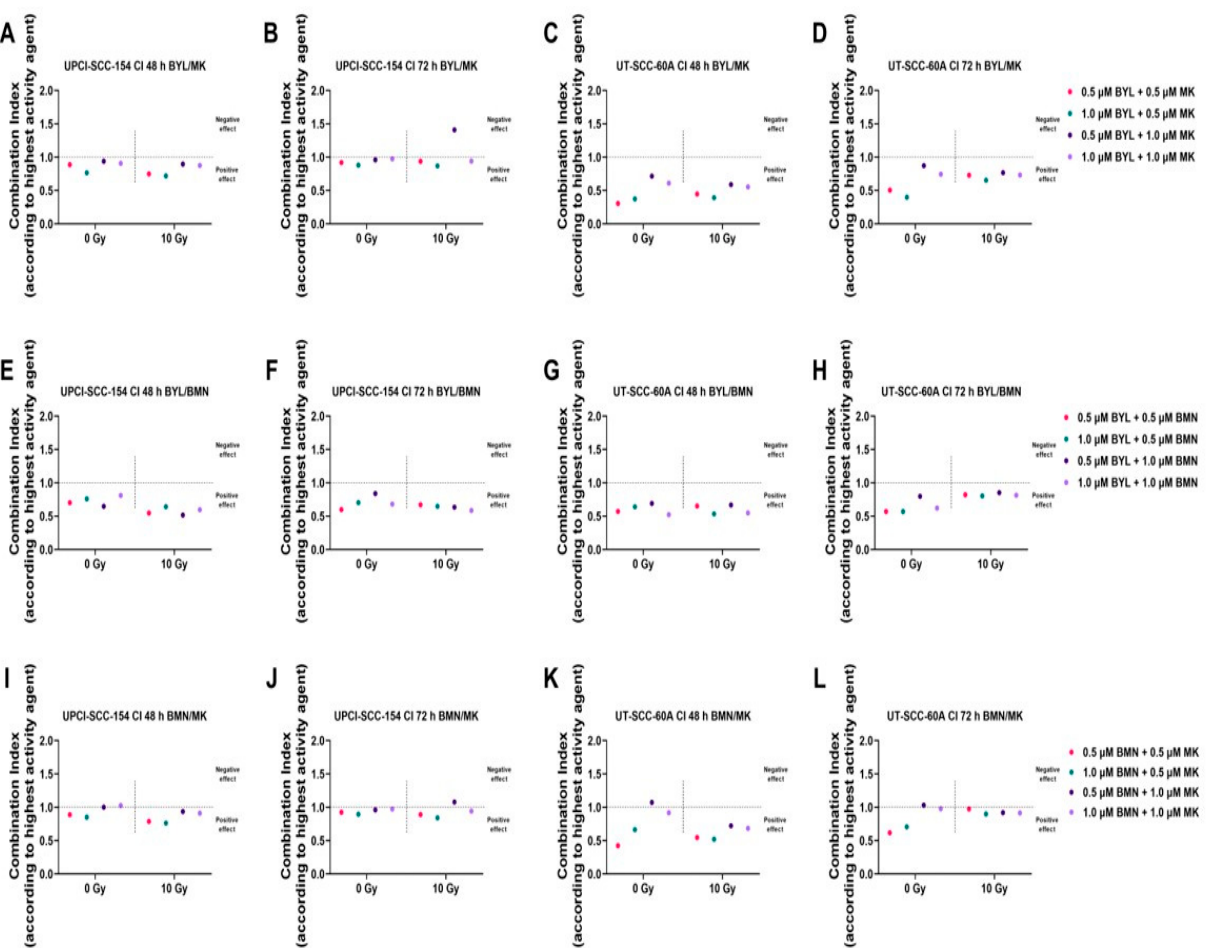
Figure 4. Combination indices (CIs) of BYL719/MK-1775 ( A – D ), BYL719/BMN-673 ( E – H ), and BMN-673/MK-1775 ( I – L ) with 0 or 10 Gy on HPV + UPCI-SCC-154 and HPV − UT-SCC-60A cell lines after 48 and 72 h of treatment. CIs were shown with the highest single agent approach after 48 and 72 h, where CI < 1 shows a positive and CI > 1 a negative combination effect. BYL denotes BYL719, BMN denotes BMN-673, and MK denotes MK-1775.